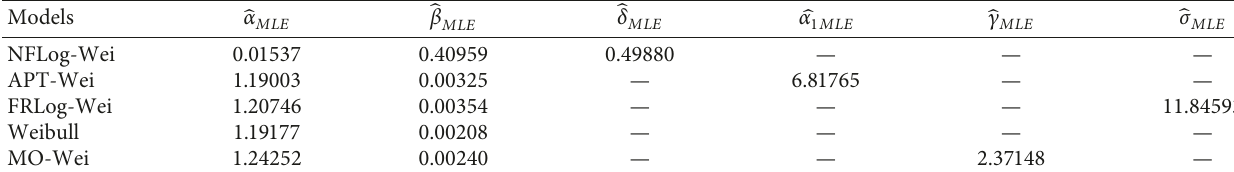
, 􏽢 β , 􏽢 δ , 􏽢 α , 􏽢 c MLE MLE MLE , and MLE 1 MLE